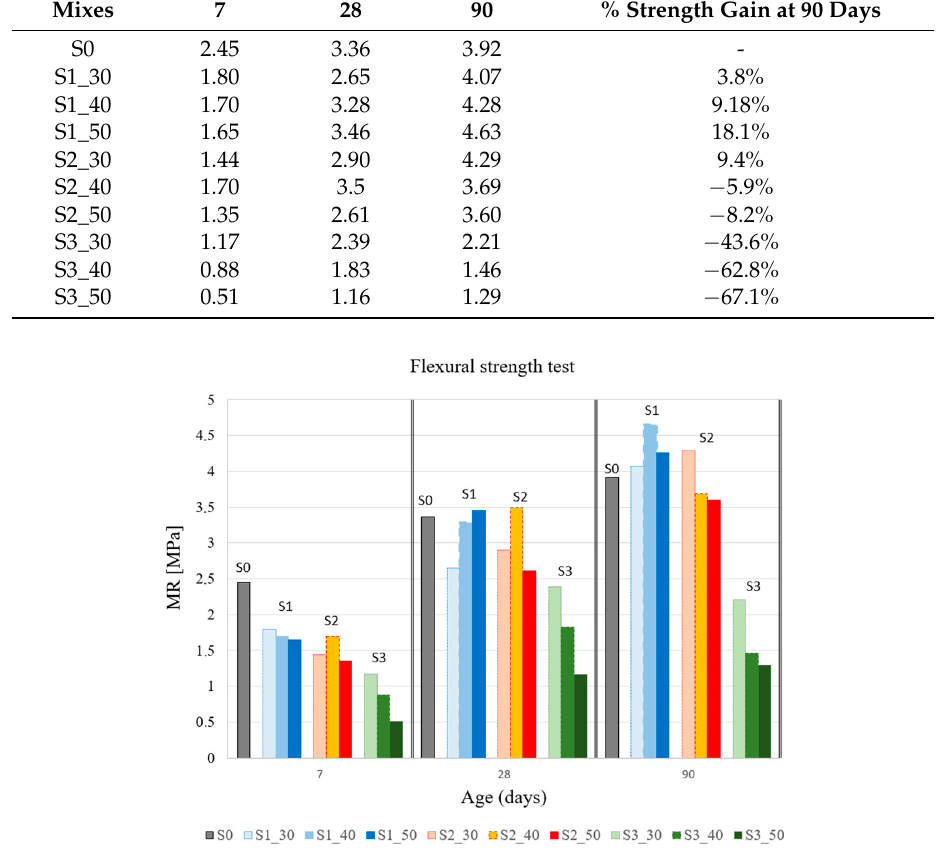
Figure 4. Results of flexural strength test (MR)(MPa).